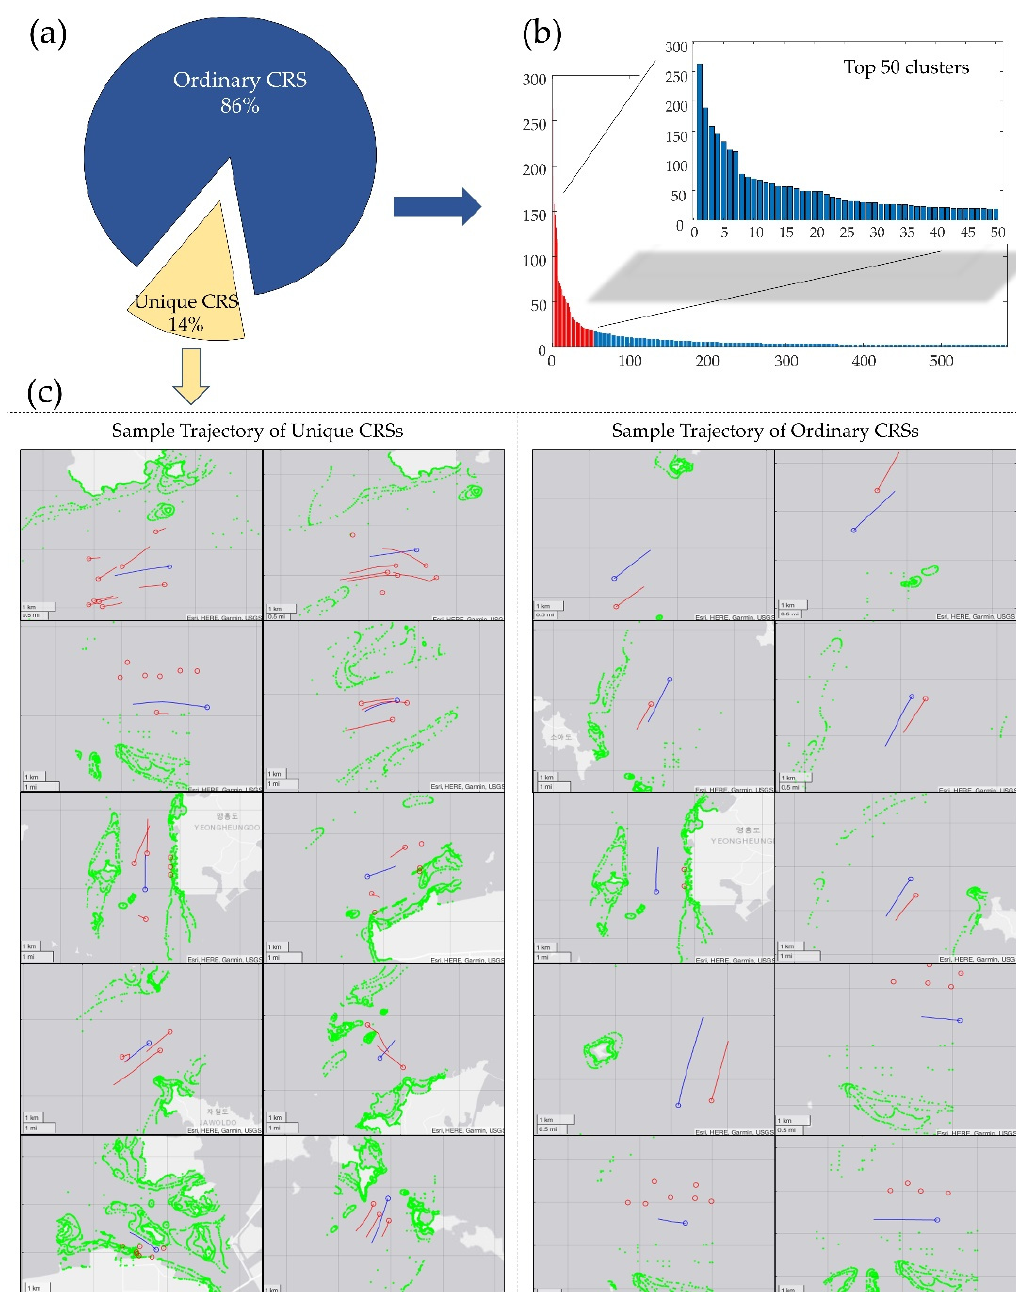
Figure 14. Ratio and sample trajectories of the ordinary and unique CRSs: ( a ) Ratio of “Ordinary”, and “Unique” group, ( b ) The frequency of clusters in the ordinary group, ( c ) Sample trajectory of Ordinary and Unique